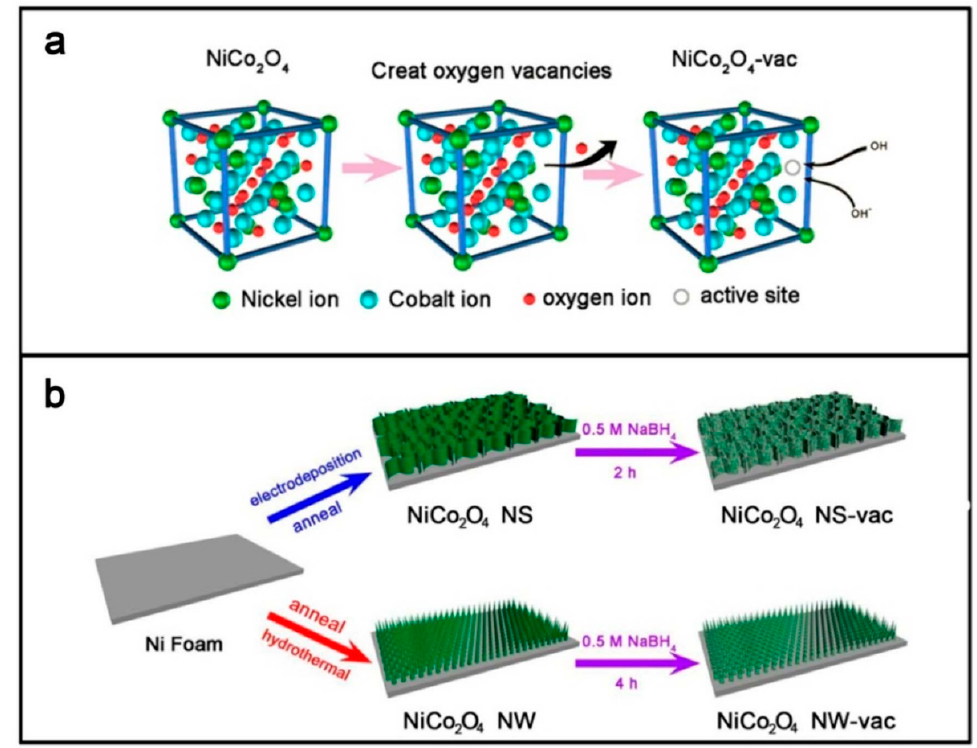
Figure 8. ( a ) Schematic diagram of oxygen vacancies in NiCo 2 O 4 ; ( b ) the preparation scheme of the electrodes. Reproduced with permission from [171]. Copyright 2018